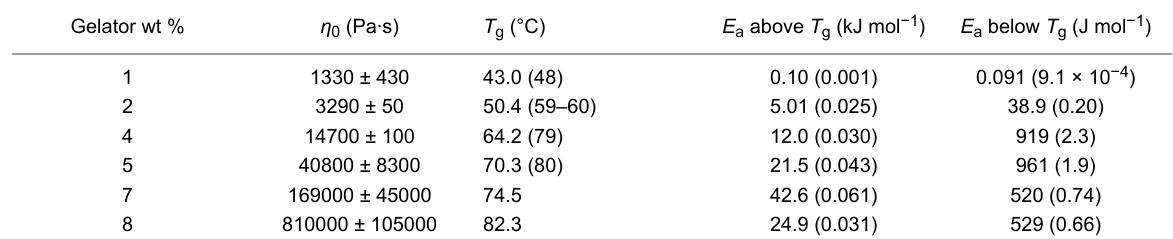
Table 1: Values of η 0 from Figure 1 and T ga from Figure 3. The activation energies ( E a ) b have been calculated from Arrhenius fits of the data in Figure 3, plotting ln( η ) versus 1/ T for points above and below T g . The numbers in parentheses are the E a values normalized for LMOG content by dividing the gross numbers by the weight fraction of ODA